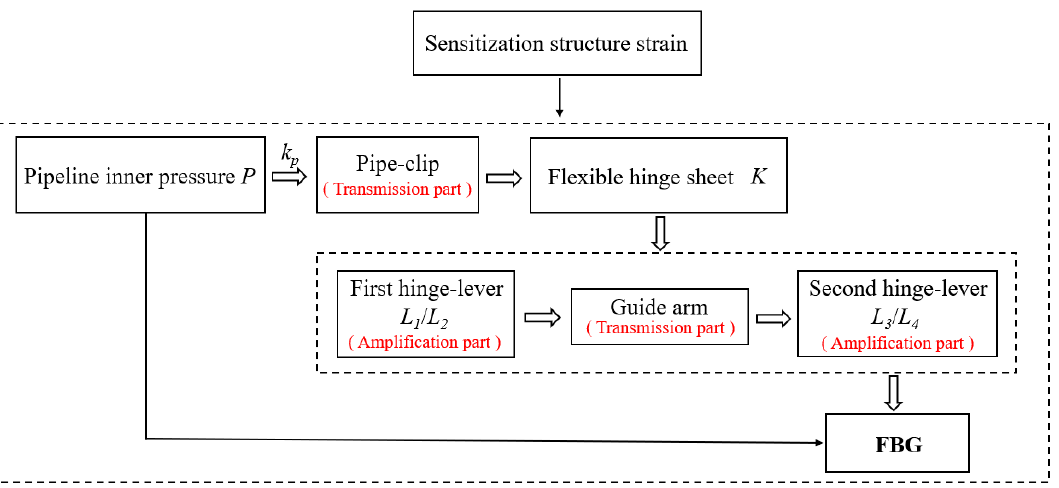
Figure 4. Flow diagrams of working principle of the sensitization structure.